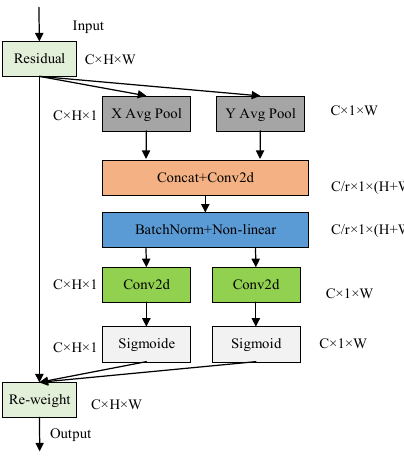
Figure 6. CA attention module.